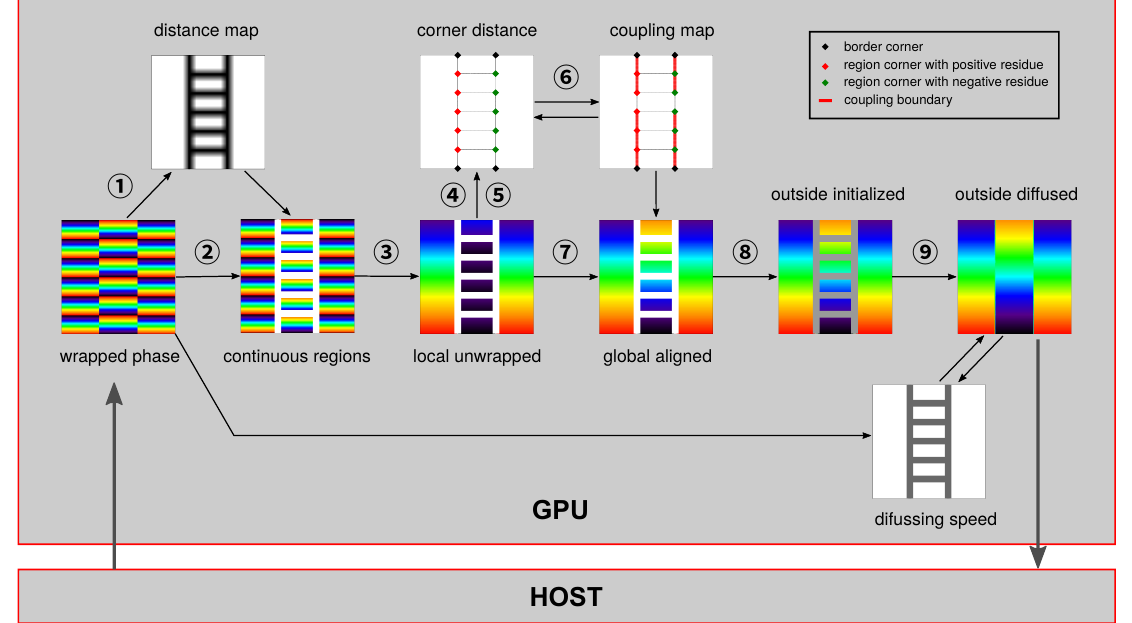
Figure 8. A simple demonstration of the processing flow for the proposed PU method based on separated continuous